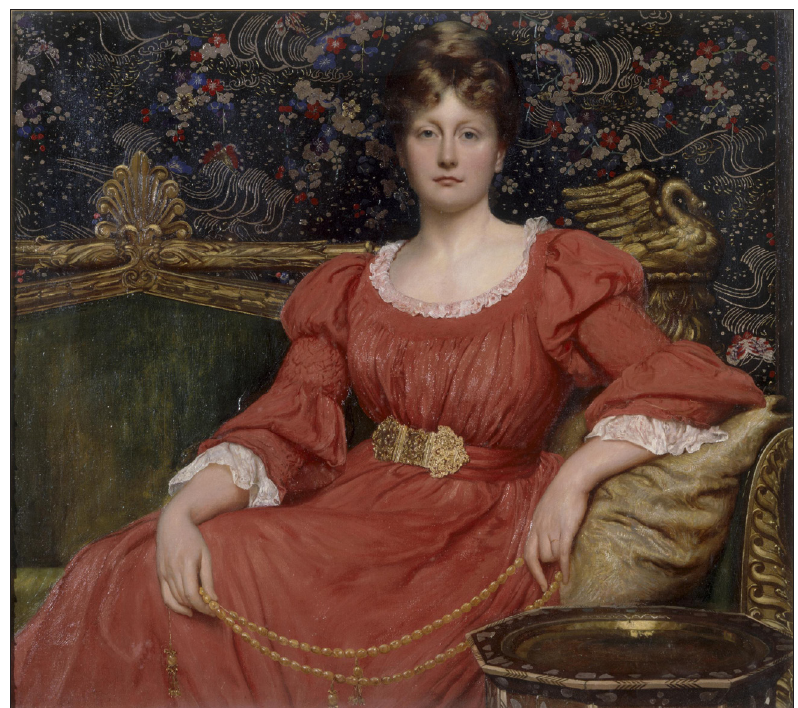
Fig. 4 : William Blake Richmond, Mrs Luke Ionides , 1879, oil on